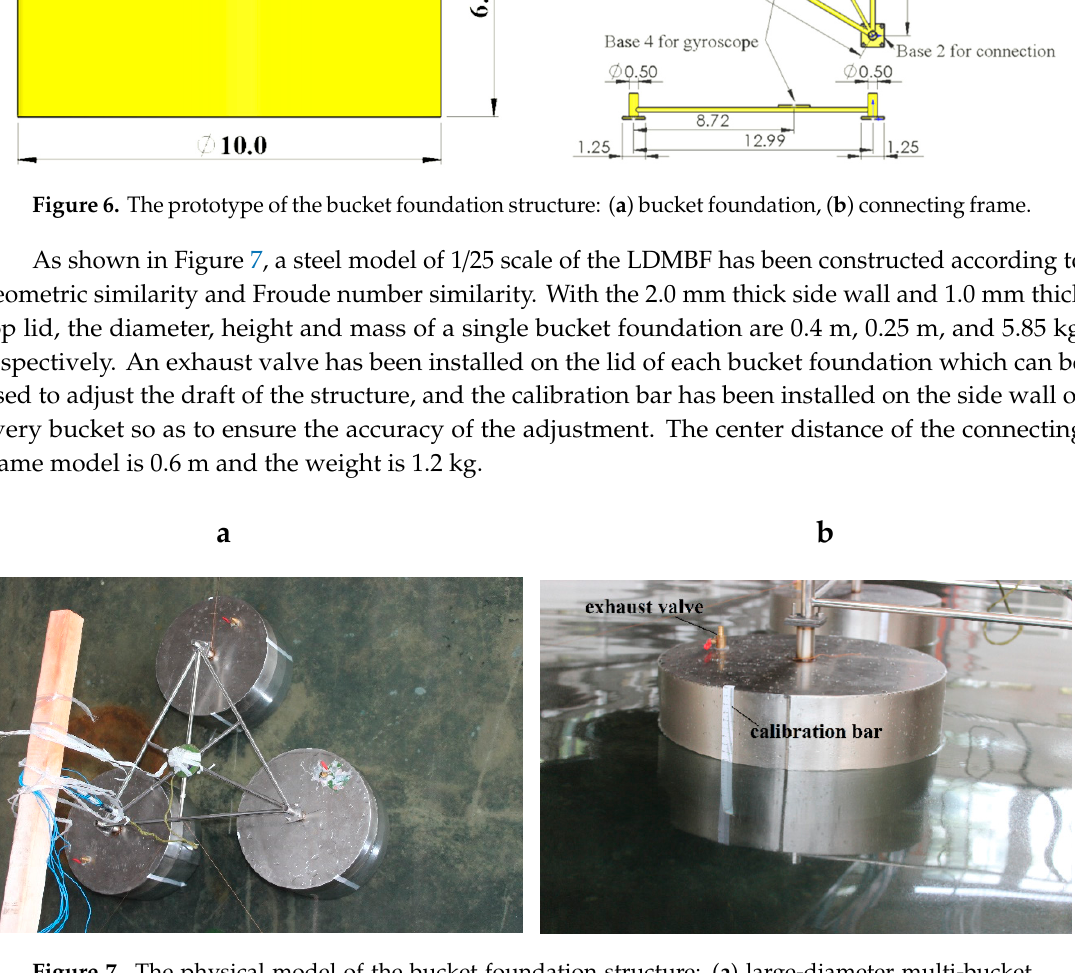
Figure 7. The physical model of the bucket foundation structure: ( a ) large-diameter multi-bucket foundation (LDMBF) structure; ( b ) bucket foundation.